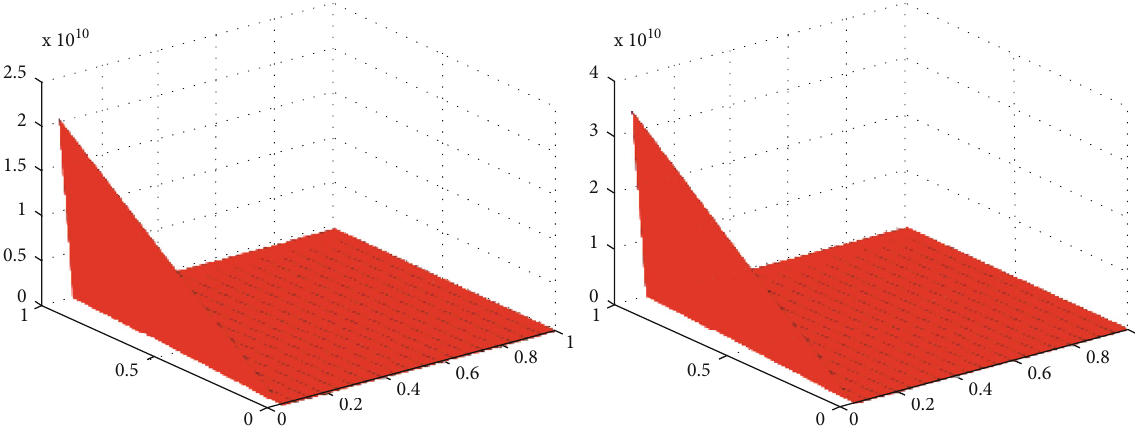
Figure 4: The fractional order of α = 0 : 8 and 0 : 6 of Problem 2.